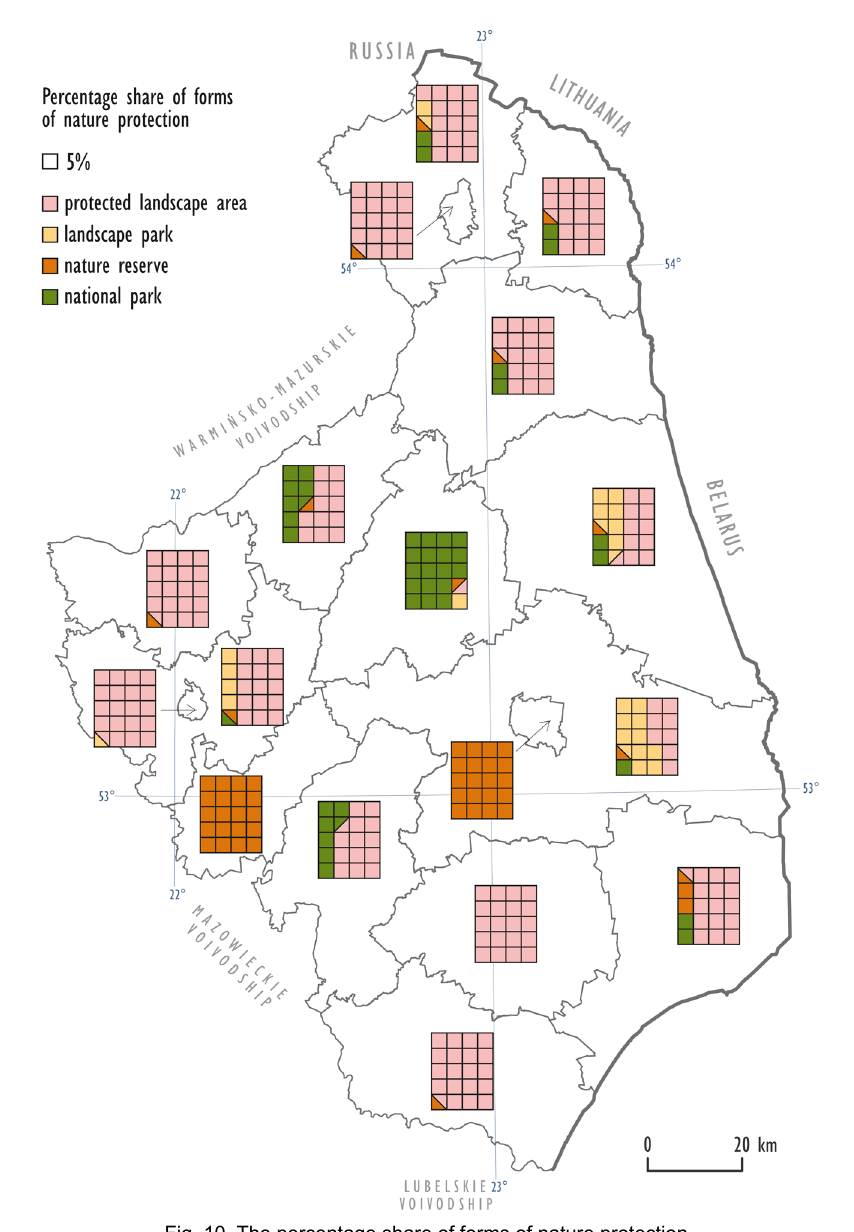
Fig. 10. The percentage share of forms of nature